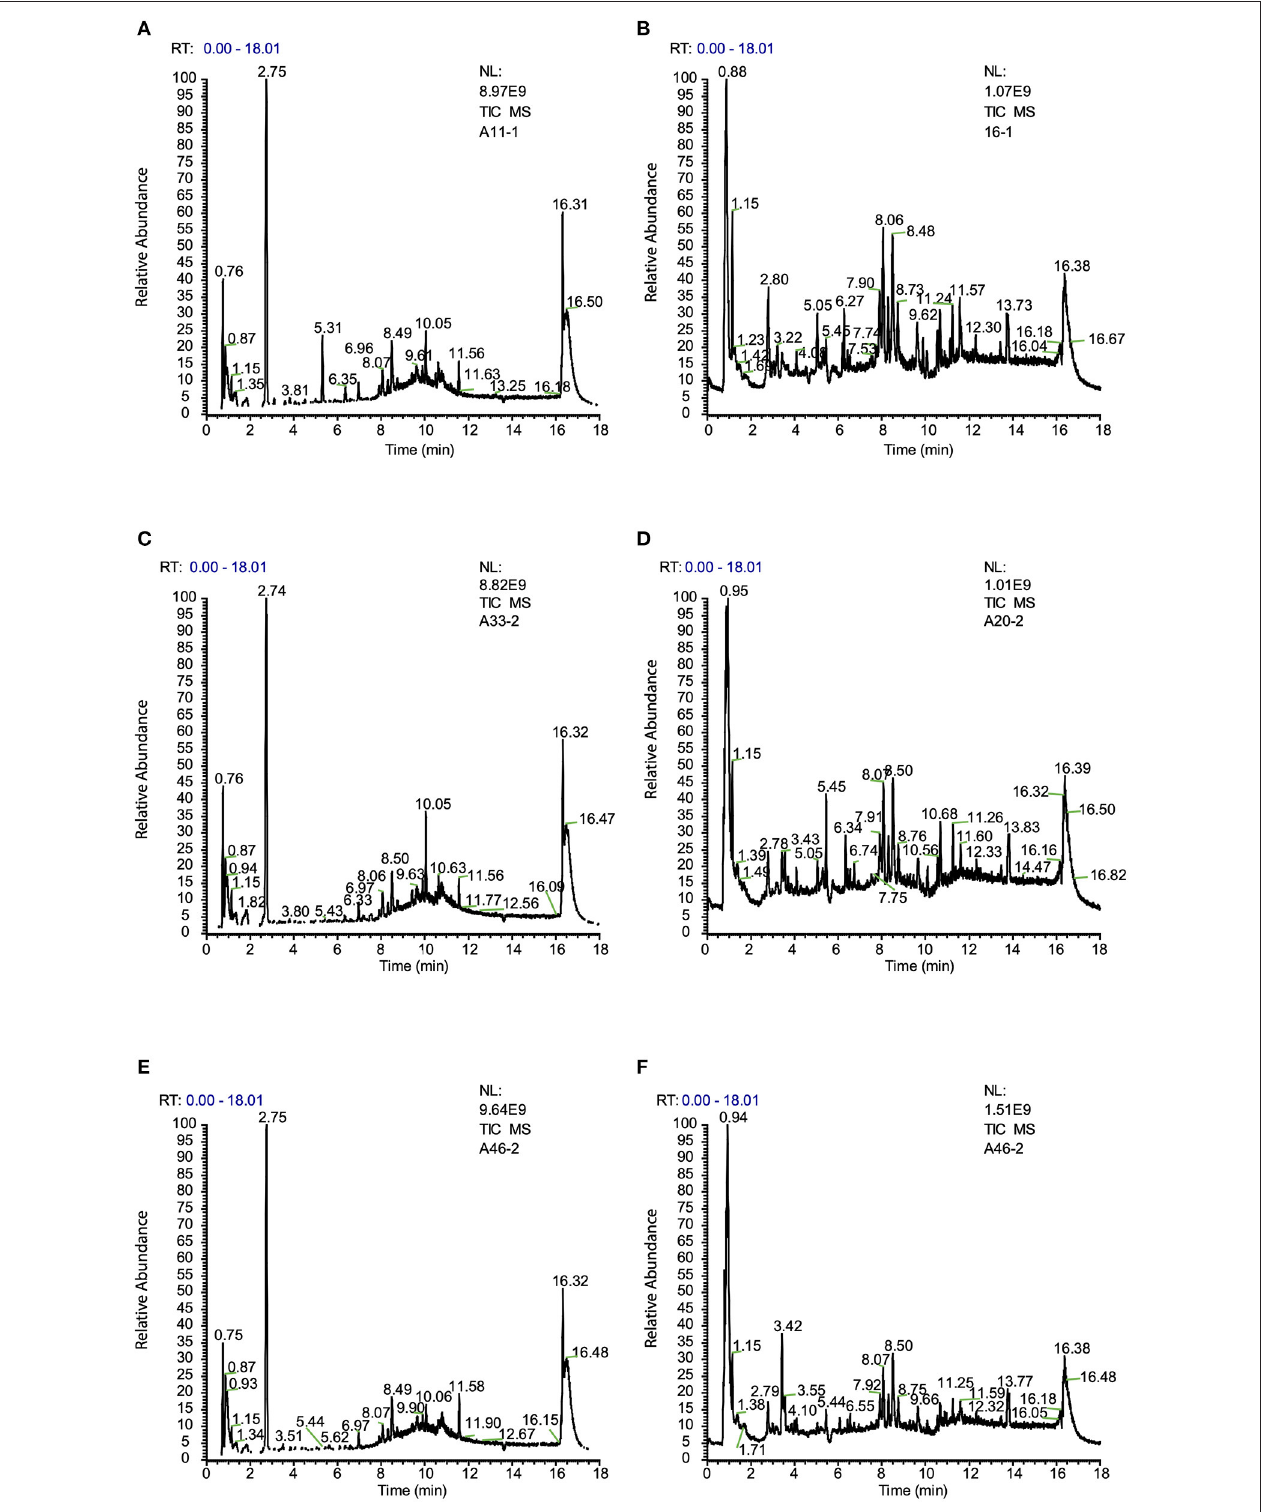
FIGURE 1 | (A) Typical ion chromatogram from preoperative sample of Non-POCD group (Non-POCD pre-op) (ESI + ). (B) Typical ion chromatogram from preoperative sample of Non-POCD group (ESI − ). (C) Typical ion chromatogram from preoperative sample of POCD group (POCD pre-op) (ESI + ). (D) Typical ion chromatogram from preoperative sample of POCD group (ESI − ). (E) Typical ion chromatogram from post-operative sample of POCD group (POCD post-op) (ESI + ). (F) Typical ion chromatogram from post-operative sample of POCD group (ESI − ).